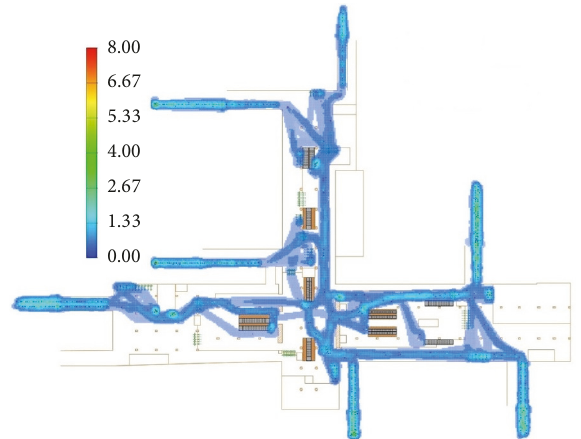
Figure 7: Crowd density map with security checks and improving measures (in 5